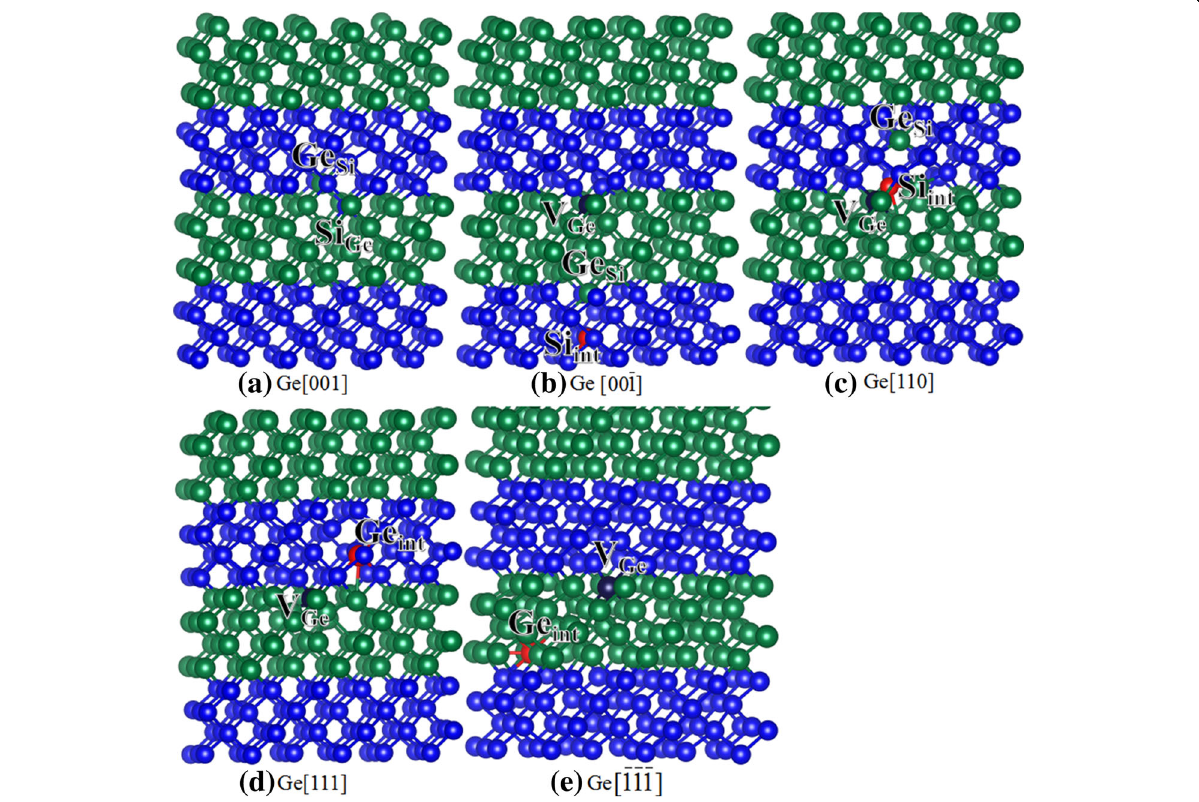
Fig. 5 a – e Schematic view of geometrical structures of damage Si/Ge superlattice after Ge recoil events. The blue and green spheres represent the Si and Ge atoms, respectively. V X : X vacancy ( X = Si or Ge); X int : X interstitial ( X = Si or Ge); X Y : X occupying the Y lattice site ( X and Y = Si or Ge). The purple and red spheres represent the vacancy and interstitial defects,